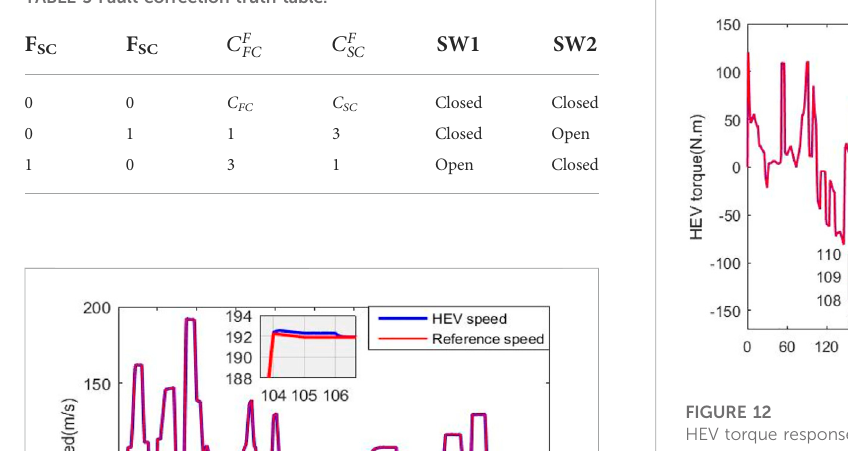
TABLE 5 Fault correction truth table.